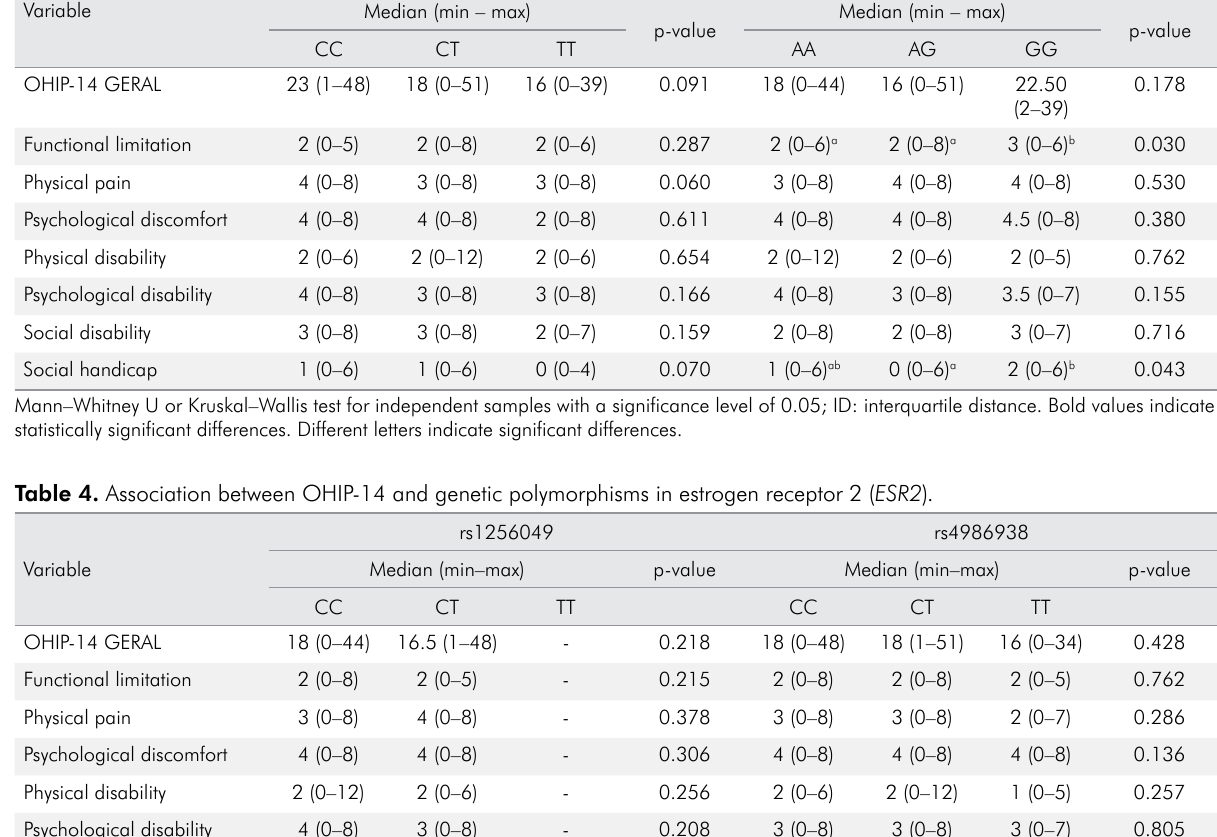
Table 3. Association between OHIP-14 scores and genetic polymorphisms in the estrogen receptor 1 ( ESR1 ). Variable